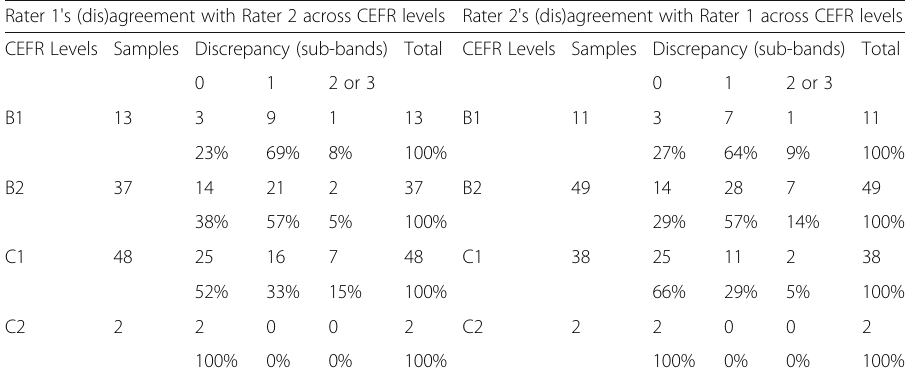
Table 8 Distribution of (dis)agreement between Raters 1 and 2 across CEFR